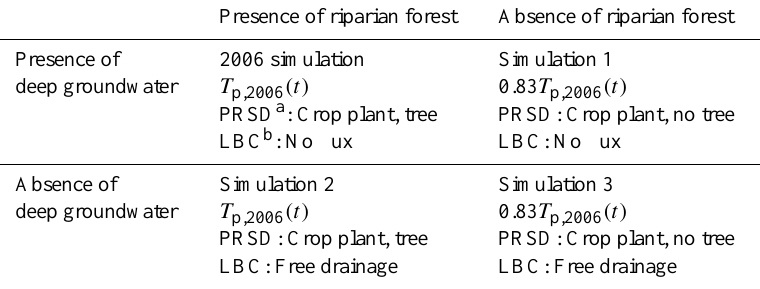
Table 3. Characteristics of the virtual experiment